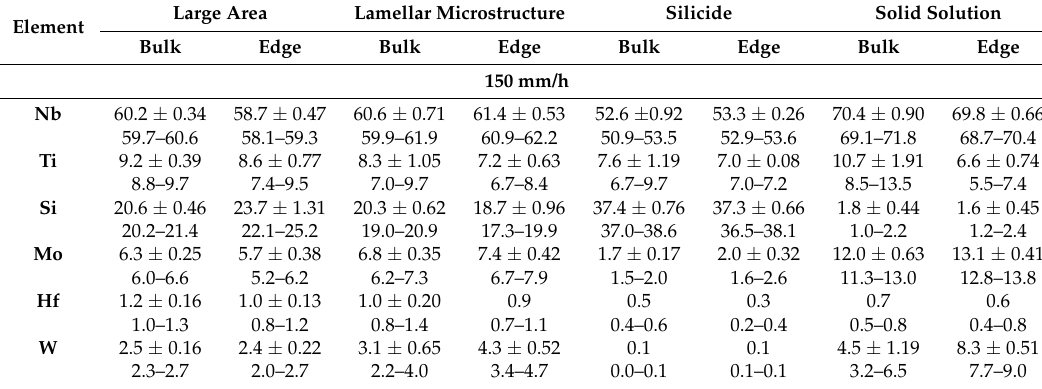
Table 2. Analysis data (at.%) of cast